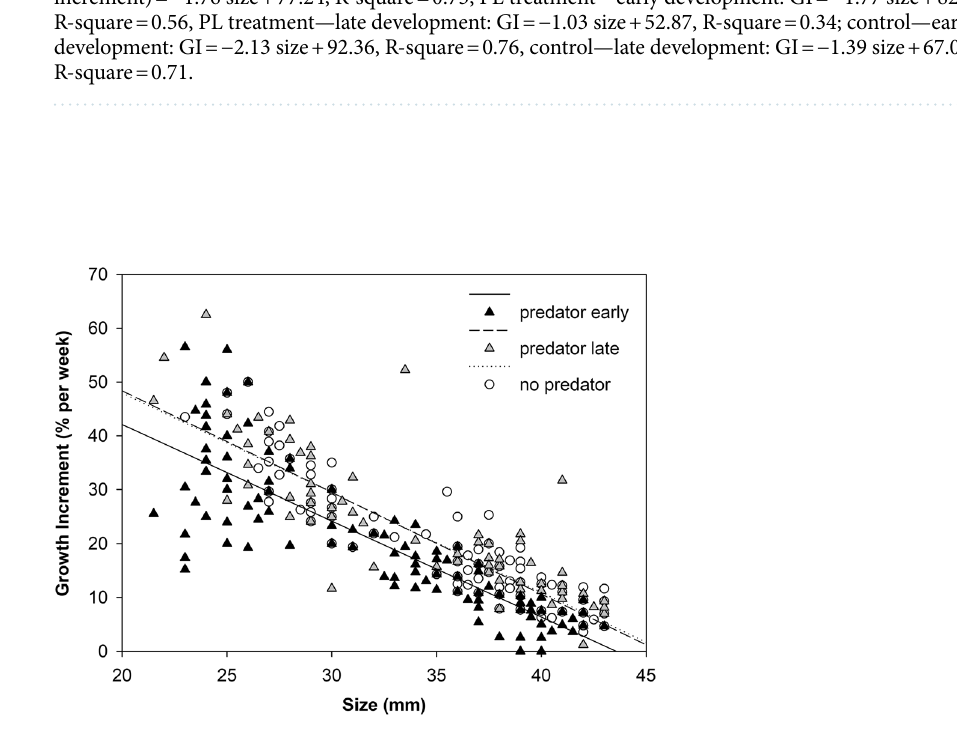
Figure 5. Relationship between growth increment and size for the size categories from 21.5 to 43.0